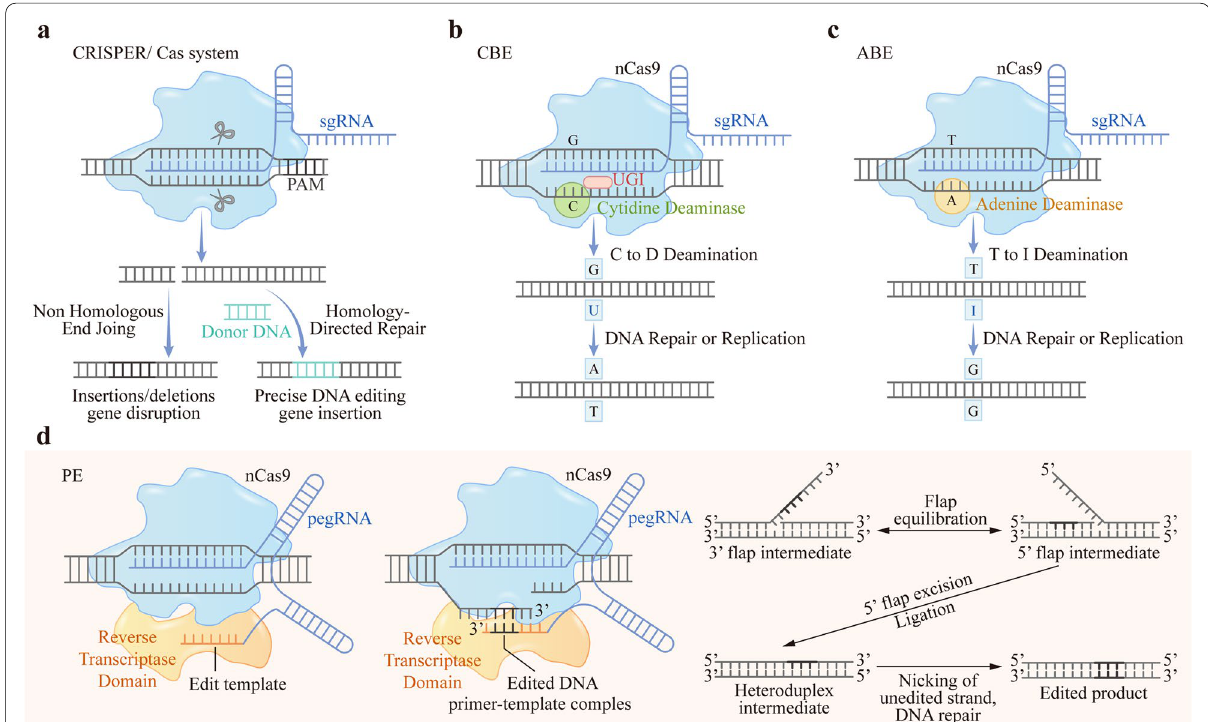
Fig. 1 Mechanisms of CRISPR/Cas system, BE and PE. A CRISPR/Cas system and NHEJ or HDR mechanisms of DSBs repair. The endonuclease Cas9 is directed to a specific genomic locus and cuts the double stranded DNA, targeted genes can be deleted and repaired via NHEJ. With a donor DNA template, targeted genes can be edited via HDR. B The mechanism of CBE. CBE mediates the direct conversion of cytidine to uridine even when located in different sequence motifs, resulting in a C G to T A transition. C The mechanism of ABE. ABE alters its base pairing preferences by · · yielding inosine. Inosine prefers to pair with guanosine under specific conditions, resulting in an A T to G C transition. D The mechanism of PE. PE is · · composed of a RT fused to Cas9 nickase and a pegRNA, mediates targeted indels and all 12 base-to-base conversions in mammalian